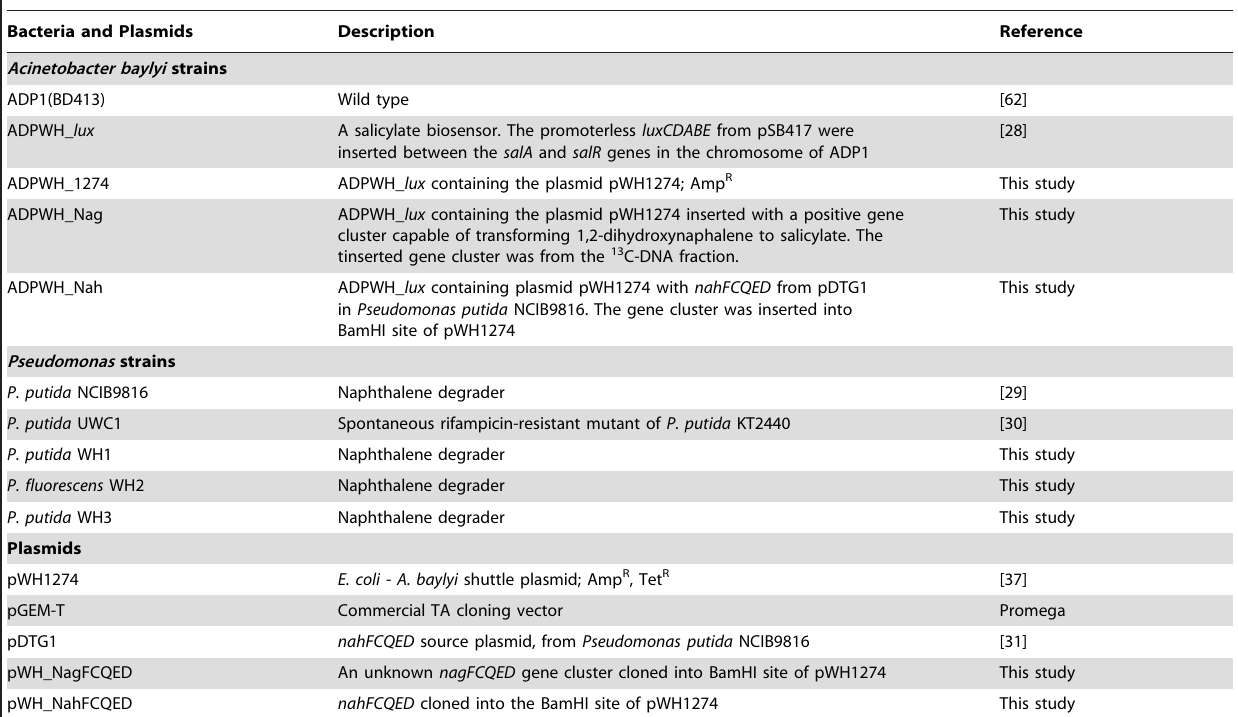
Table 2. Strains and plasmids used in this study.